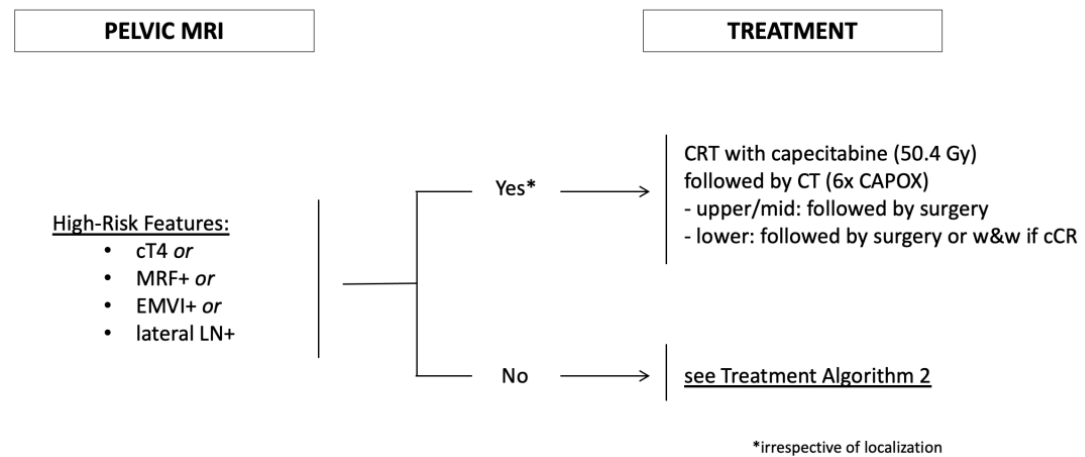
Figure 1. Treatment Algorithm 1: Risk-stratified treatment of rectal cancer. MRF+ (involvement of mesorectal fascia); EMVI+ (presence of extramural vascular invasion); lateral LN+ (suspicious lateral pelvic lymph nodes, located along the iliac and obturator arteries); CRT (chemoradiation); CT (chemotherapy).